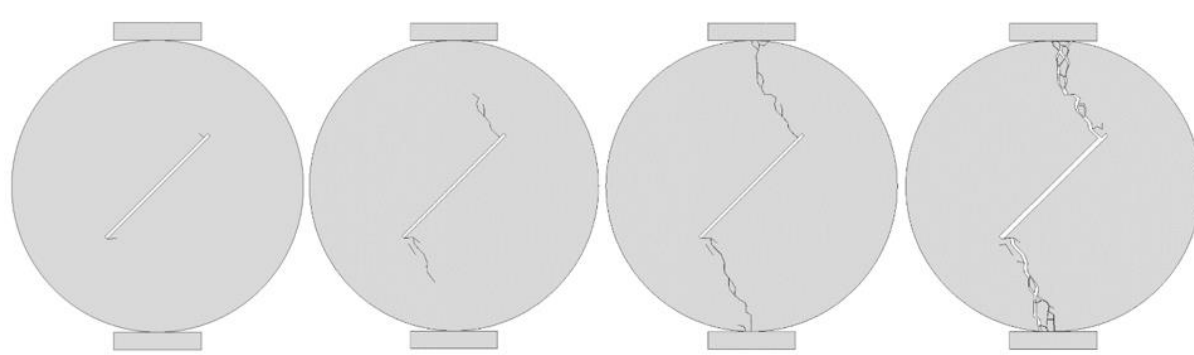
Figure 6. Fracture process for Brazilian disc with a crack of 45° angle.